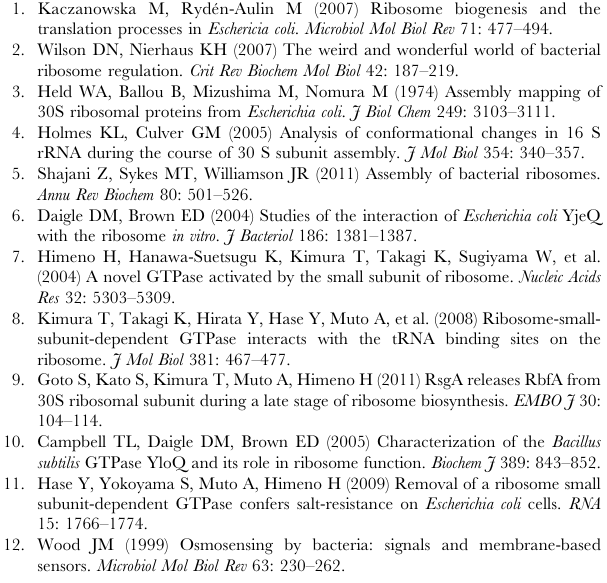
Figure 4. Premature and transient induction of genes regulated by s E . Cells in which a ribosome maturation factor or a ribosomal protein was removed (A–C) and wild-type cells treated with 80 m g/ml kasugamycin, 1.2 m g/ml chloramphenicol or 2.5 m g/ml streptomycin (D) were used. Levels of rpoE mRNA (A and D), rpoH mRNA (B) and MicA (C) at the indicated time points after salt shock were analyzed by qRT-PCR. Total RNA fraction prepared from each of the cells was used as the